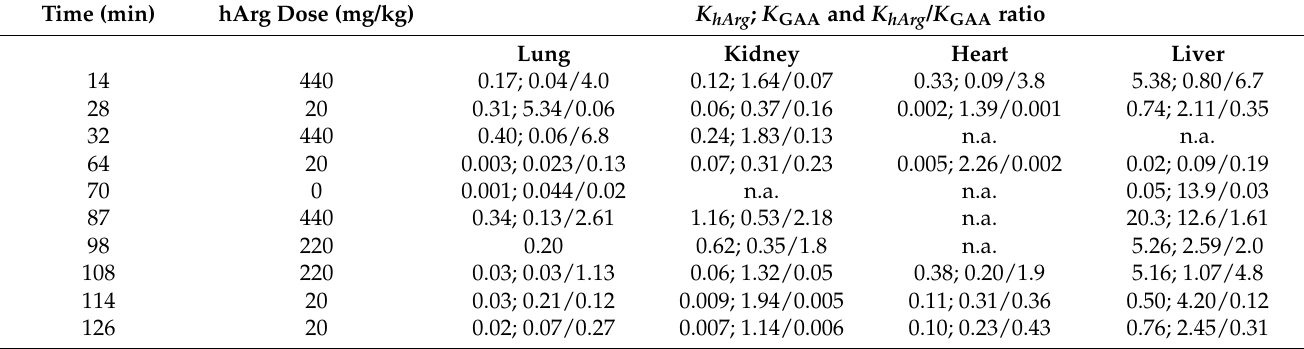
Table 4. Equilibrium constant ( K hArg ) values of the AGAT-catalyzed reaction Arg + Lys ↔ hArg + Orn, equilibrium constant ( K GAA ) values of the AGAT-catalyzed reaction Arg + Gly ↔ GAA + Orn, and their K hArg / K hArg ratio in the organs of the rats at the time of sacrifice upon i.p. administration of the indicated doses of hArg. n.a., not